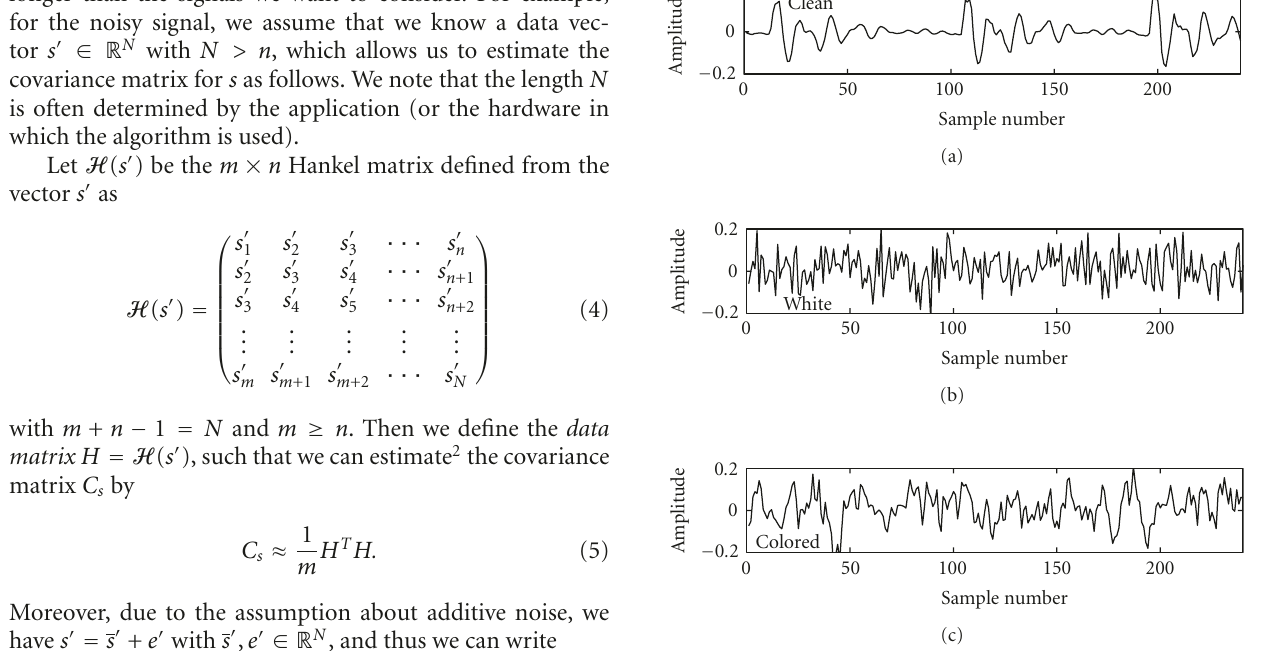
Figure 1: The three signals of length N = 240 used in our exam- ples. (a) Clean speech signal (voiced segment of male speaker); (b) white noise generated by Matlab’s randn function; (c) colored noise (segment of a recording of strong wind). The clean signal slightly vi- olates the subspace assumption (3), see Figure